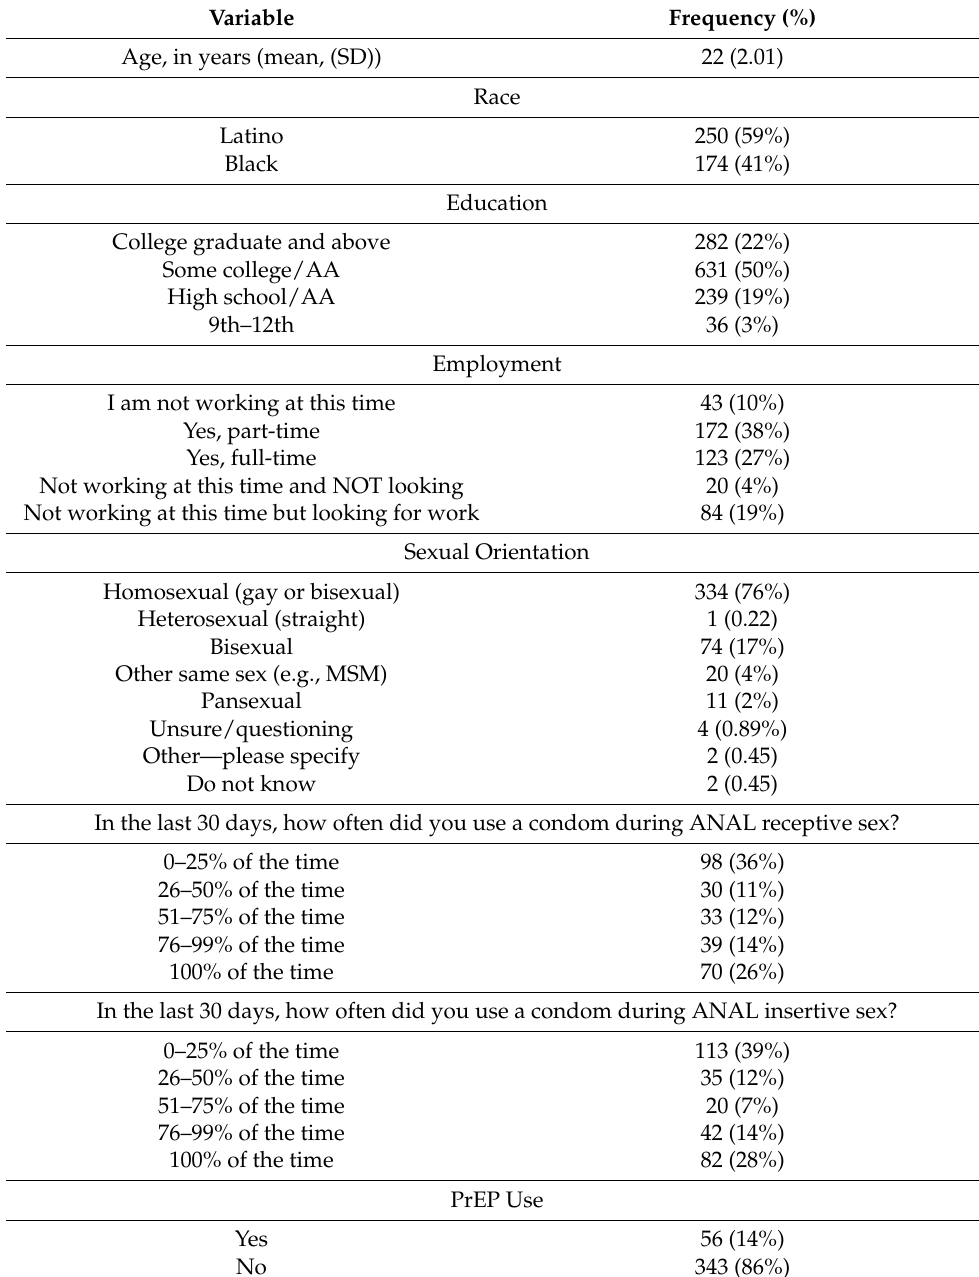
Table 1. Sample Characteristics ( n =